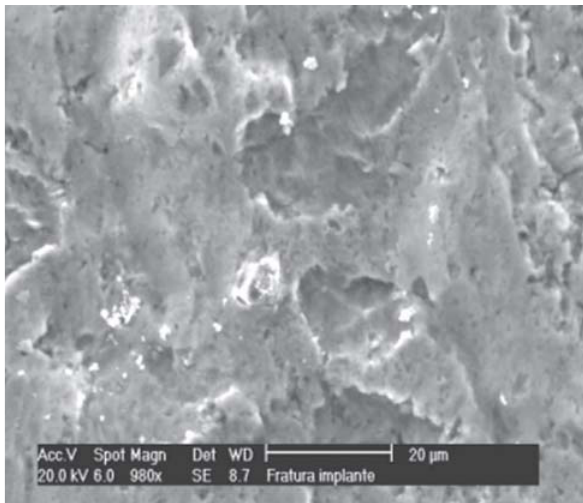
FIGURE 2 - Higher magnification of the initial fracture reveals the squashing caused by compressive strengths and absence of “dimples”, which characterizes that this was the first portion to fracture, and chewing promoted surface smoothing until occurrence of fracture of the first implant at the same time